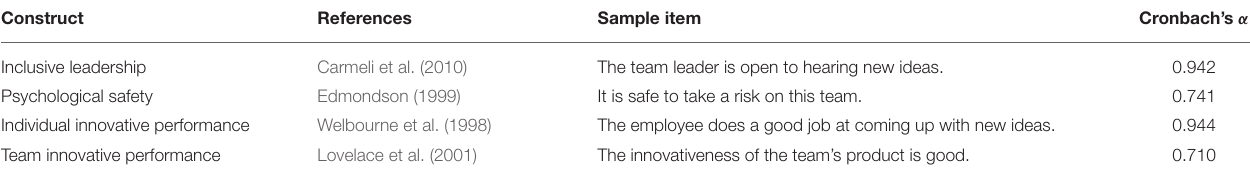
TABLE 1 | Summary of constructs in this